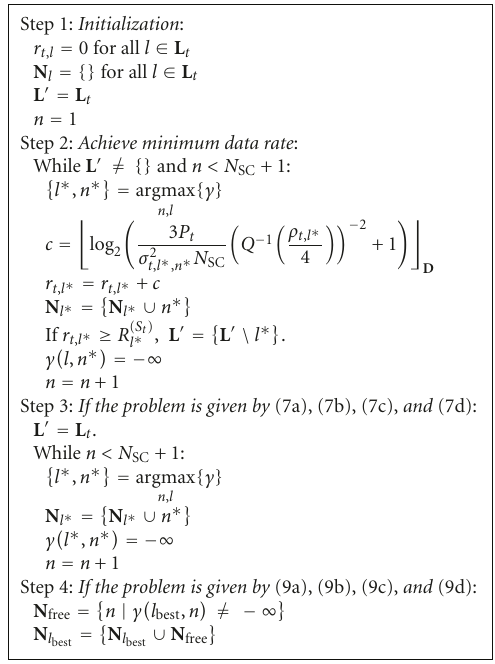
Figure 2: Subcarrier allocation